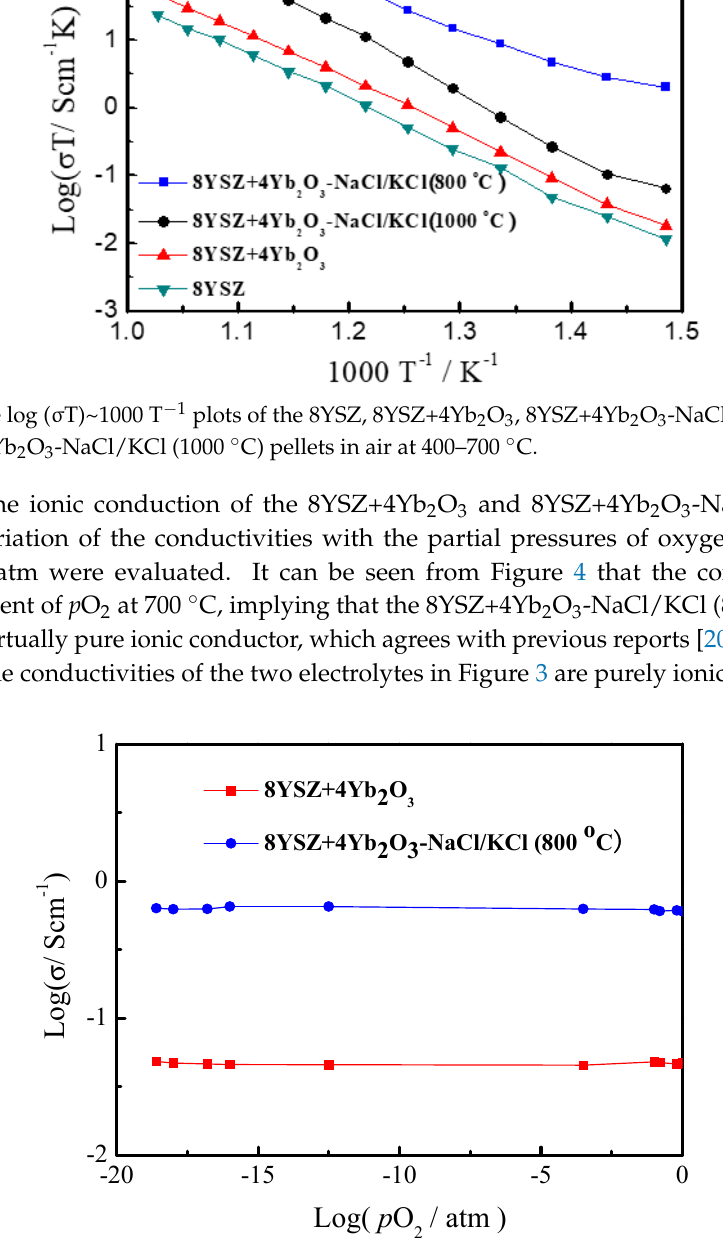
Figure 4. The conductivities of the 8YSZ+4Yb 2 O 3 and 8YSZ+4Yb 2 O 3 -NaCl/KCl (800 °C) as a function of p O 2 at 700 °C.